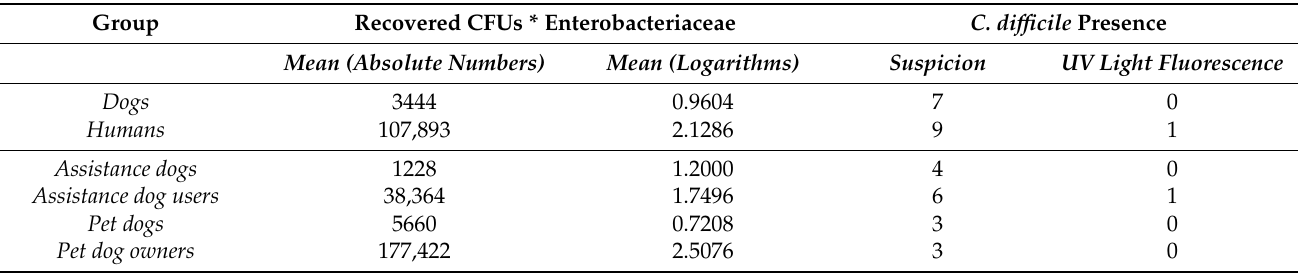
Table 3. Microbiological analysis results: data used for (paired) t